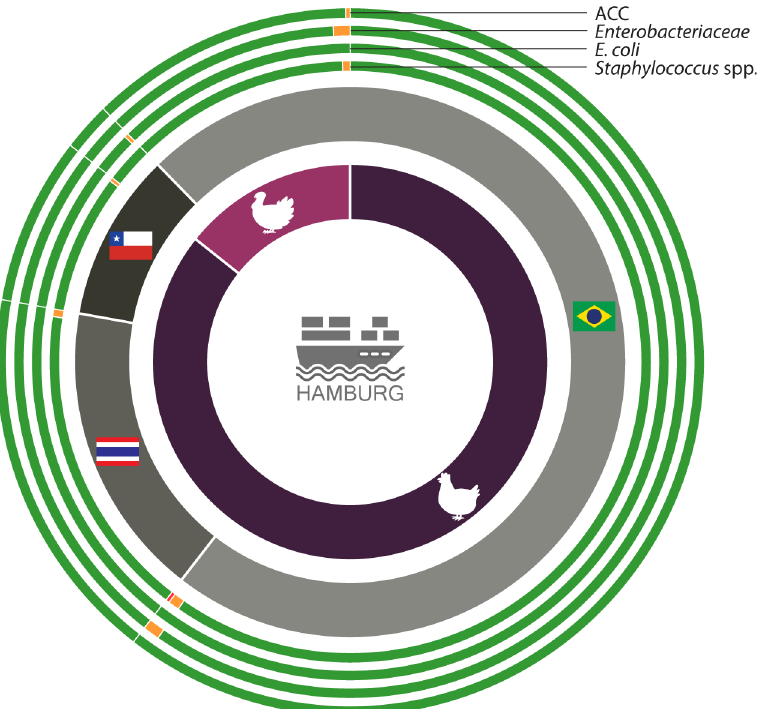
Fig 3. Classification of fresh poultry meat according to the species (inner circle: chicken and turkey) and country of origin (central circle: Brazil, Thailand and Chile) in three quality categories in accordance with microbiological criteria of the DGHM in per cent [%] (outer circle): (1) satisfactory (green); (2) acceptable (yellow), and (3) unsatisfactory (red).